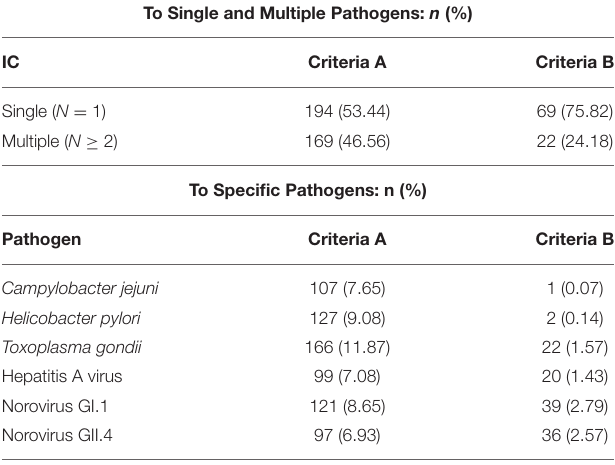
TABLE 1 | Immunoconversions to target pathogens: number ( n ) and percentage (%) of individuals that immunoconverted. To Single and Multiple Pathogens: n